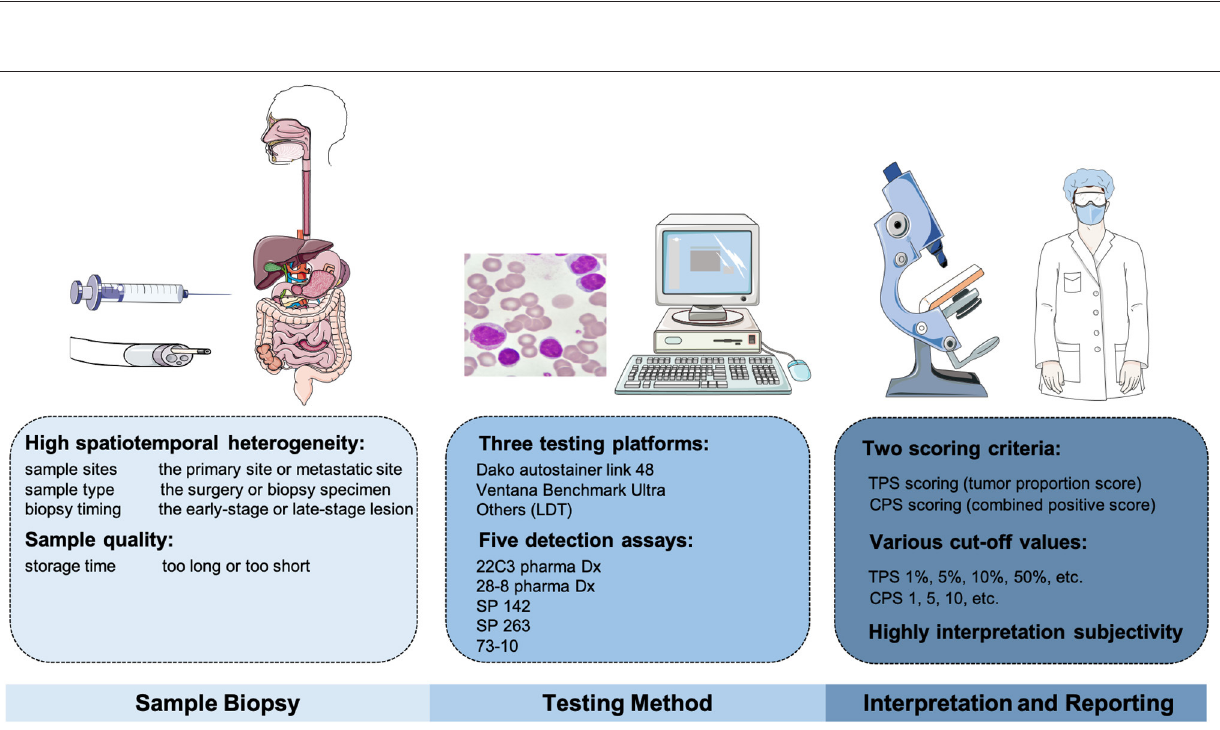
Frontiers in Oncology |